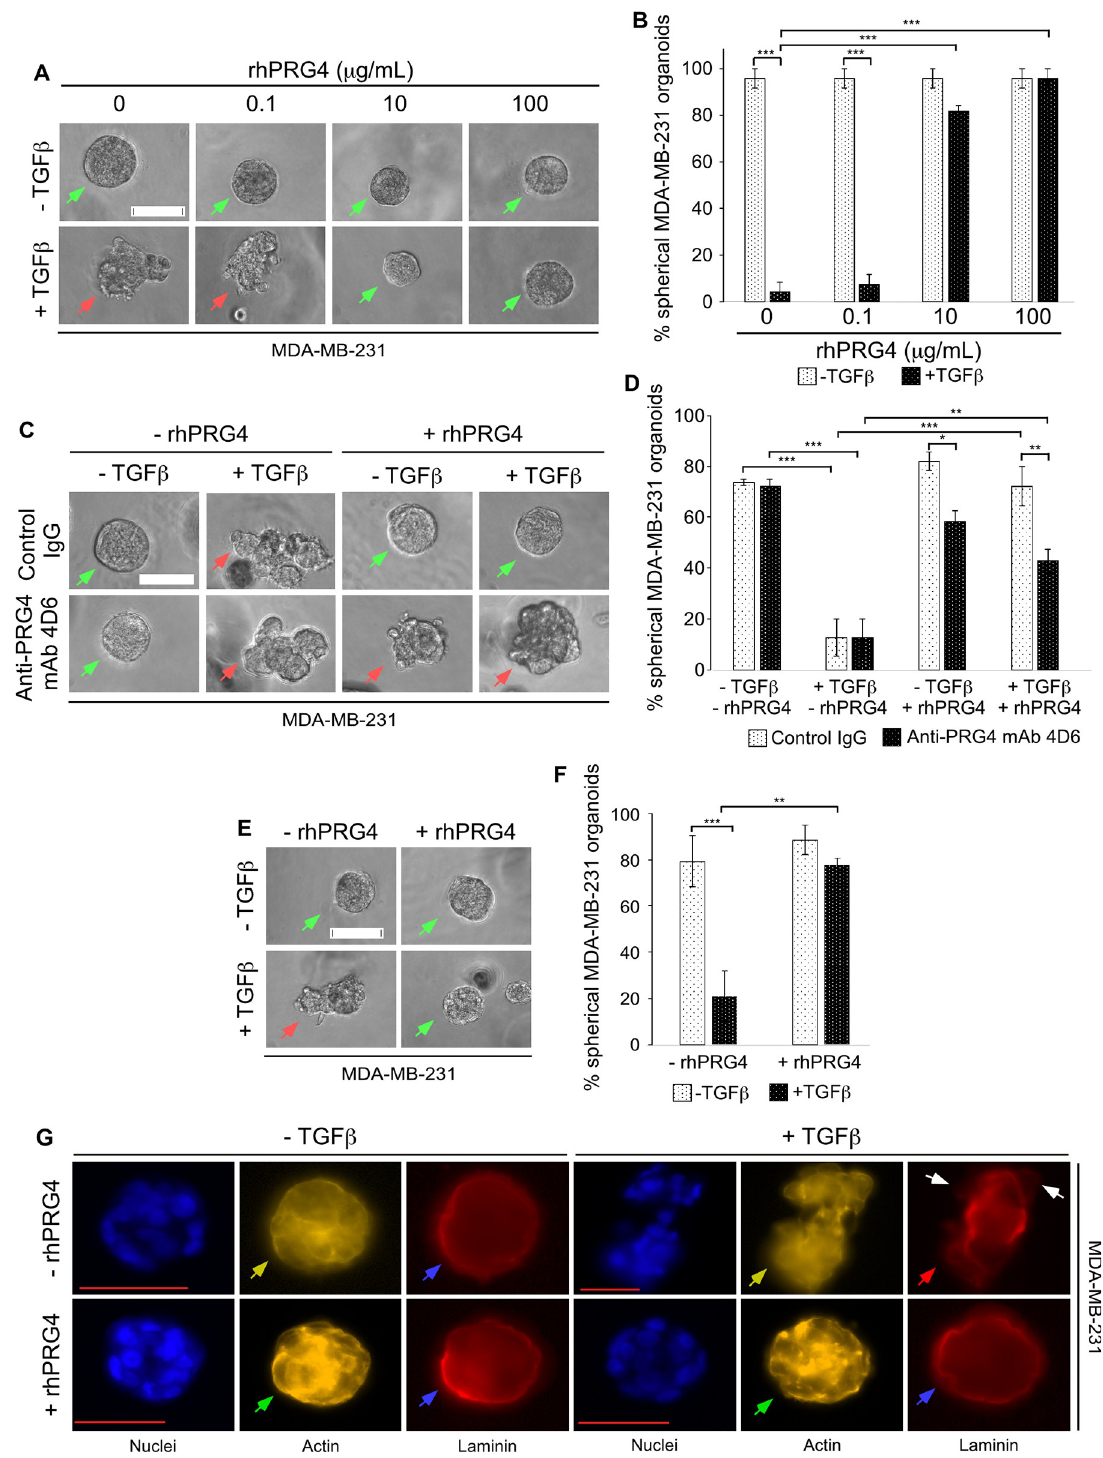
Fig 1. rhPRG4 suppresses TGF β -induced invasive growth of MDA-MB-231 cell-derived organoids. (A) Representative DIC light microscopy images of 8-day old three-dimensional MDA-MB-231 cell-derived organoids that were left untreated or incubated with 100 pM TGF β , without or with increasing concentrations of rhPRG4 (0.1, 10 and 100 μ g/mL) in complete growth medium. (B) Bar graph depicts mean ± SEM proportion of spherical organoids expressed as a percentage of total colonies counted for each experimental condition from four independent experiments including the one shown in A. (C) Representative DIC light microscopy images of 8-day